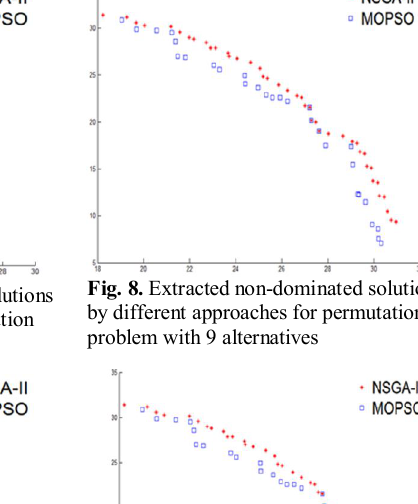
Fig. 11. Extracted non-dominated solutions by different approaches for permutation problem with 12 alternatives